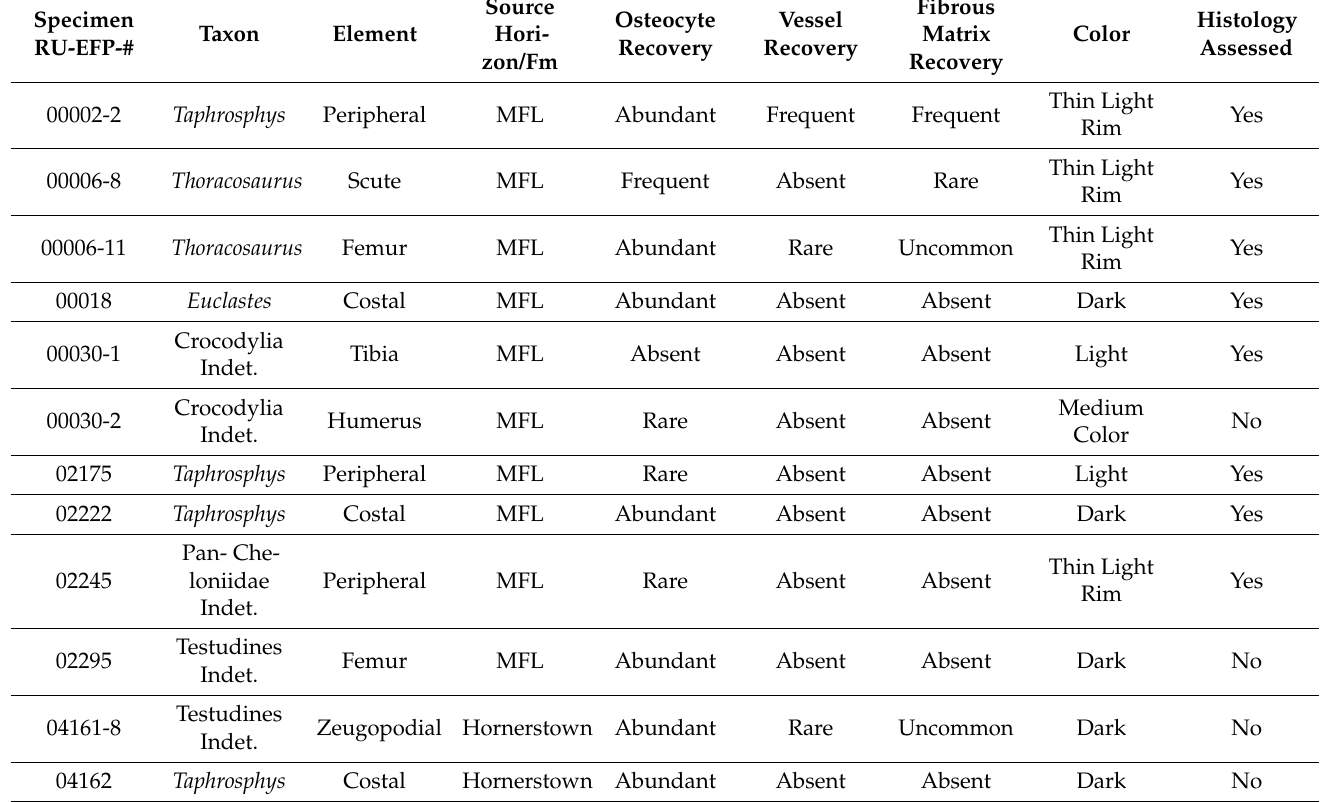
Table 2. An overview of the 12 samples analyzed in this study. Abbreviation: Fm =